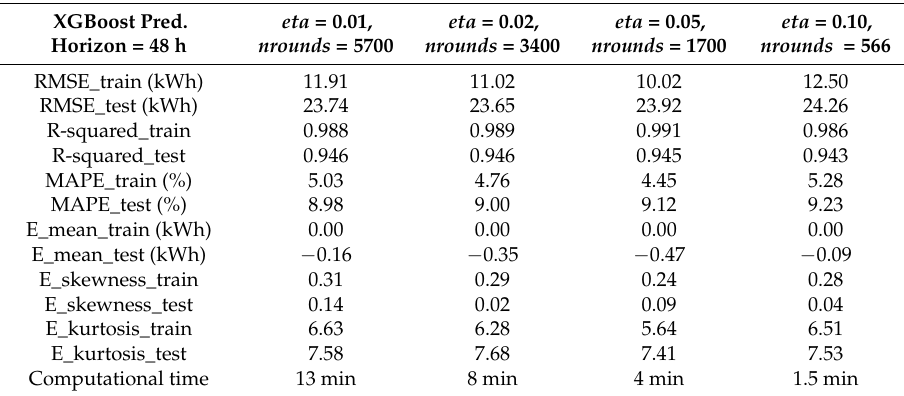
Table 4. Results of the parameter selection for the XGBoost method.